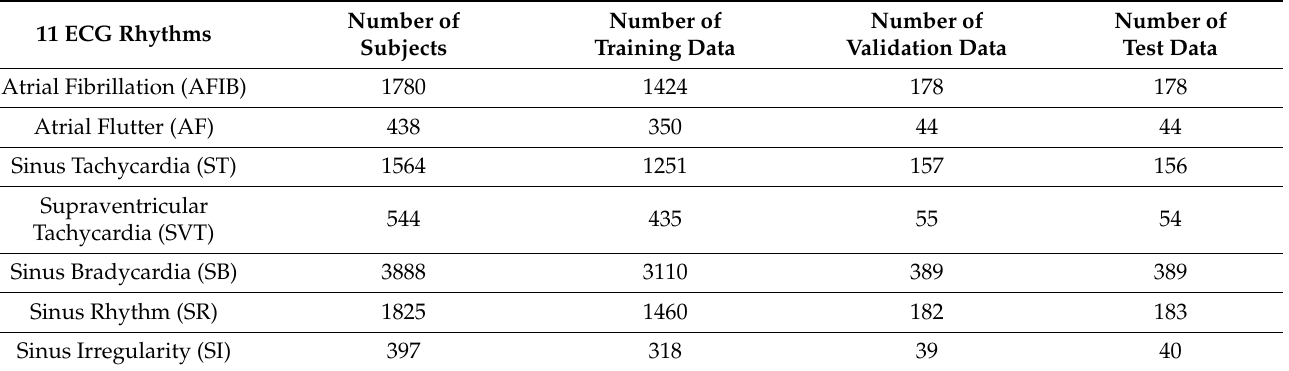
Table 1. Information on the 7 ECG